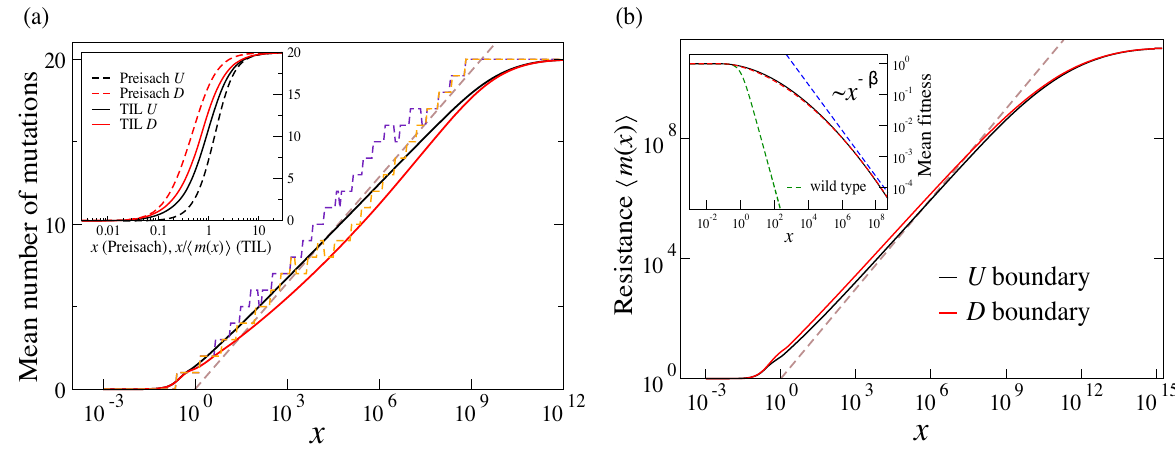
FIG. 6. Average properties of evolutionary trajectories along the main loop for L ¼ 20 . The dose-response curve is w ð x Þ ¼ 1 = ð 1 þ x 2 Þ . The mutation parameters ð r ; m i i Þ are drawn randomly from a joint probability density described by Eqs. (C1) and (C2) in Appendix C. Adaptive walks (based on selection coefficients) were used for evolutionary dynamics. Greedy walks produce very similar results and are not shown. A total of 10 4 realizations were used to calculate averages. (a) Mean number of mutations in the genotypes along the U and D boundaries, which describe the behavior under increasing ( U ) and decreasing ( D ) concentrations. The dashed purple and orange lines show a typical sample trajectory. The dashed brown line is the curve ð ln x Þ =b , where b ¼ h ln m i . The inset shows rescaled values of the mutation number in comparison to the Preisach analog (dashed lines). The rescaling is done by the mean resistance level h m ð x Þi . (b) Mean resistance level h m ð x Þi of the genotypes along the boundaries. The brown dashed curve is x . The inset shows the fitness of the genotypes along the boundaries. The dashed green line is the fitness of the wild type w ð x Þ , and the dashed blue line is the power law x − β , where β ¼ − ð a=b Þ and a ¼ − h ln r i . Angular brackets denote averages over